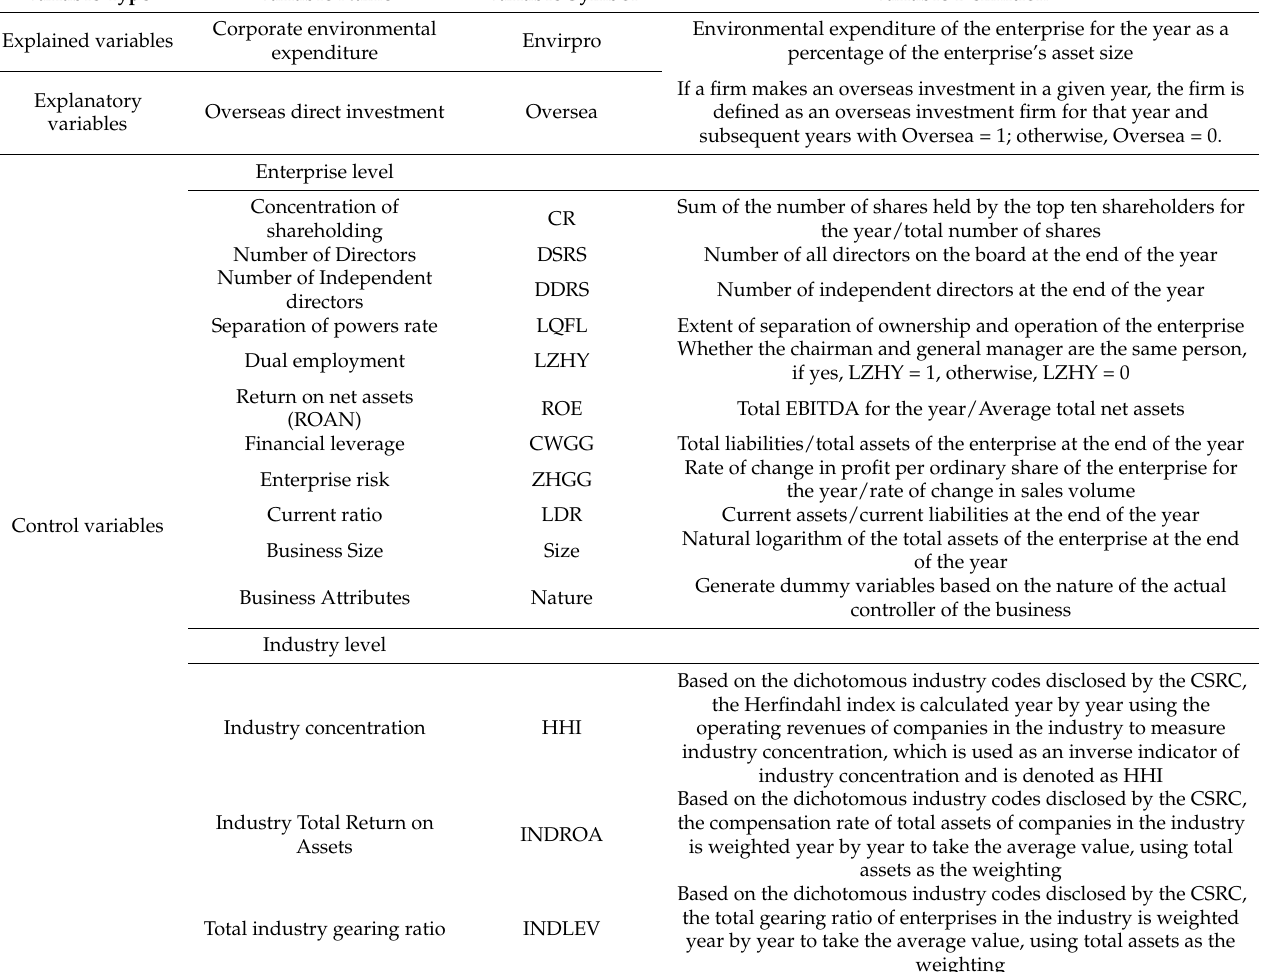
Table 1. Variable